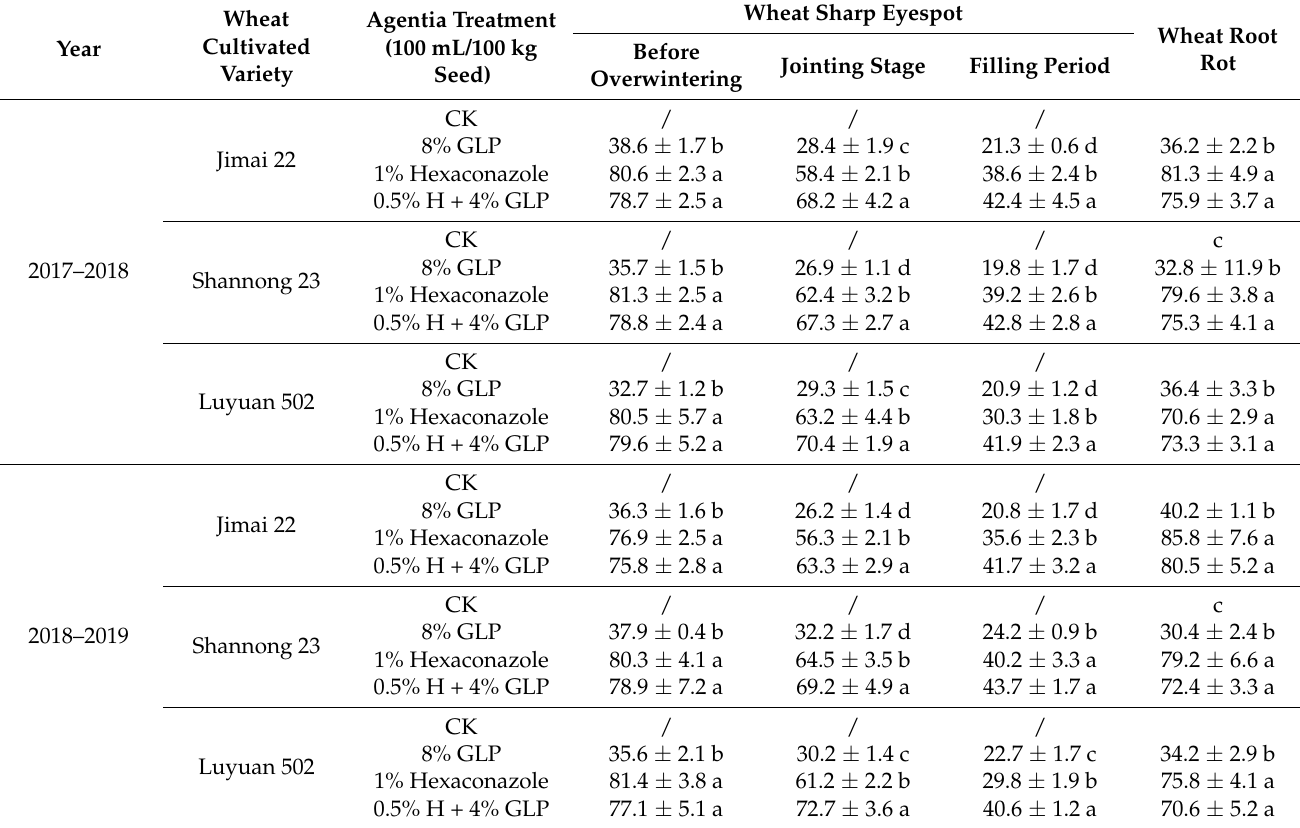
Table 12. Field control effect of seed treated on wheat sharp eyespot and wheat root